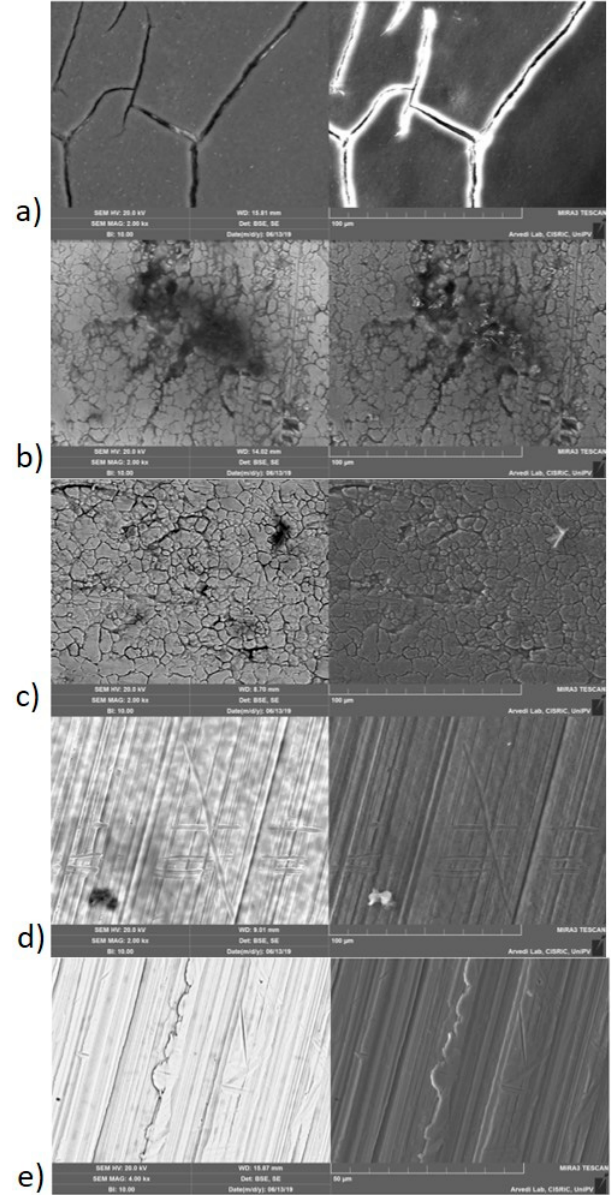
Figure 7. Scanning electron microscopy (SEM) image, using a back-scattered electrons (BSE) detector (left) or a Scattered Electrons (SE) detector (right), of: ( a ) untreated biofilm; ( b ) biofilm with 0.5 mg · mL − 1 of NAC; ( c ) biofilm with 2 mg · mL − 1 of NAC; ( d ) biofilm with 4 mg · mL − 1 of NAC; ( e ) clean steel-surface.